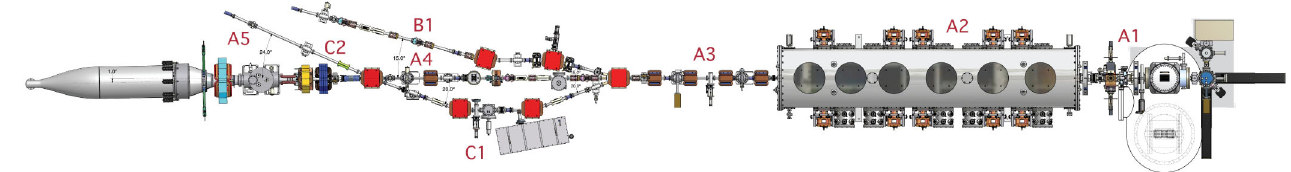
FIG. 3. A schematic of the Cornell ERL photoinjector. Beam travels from right to left.